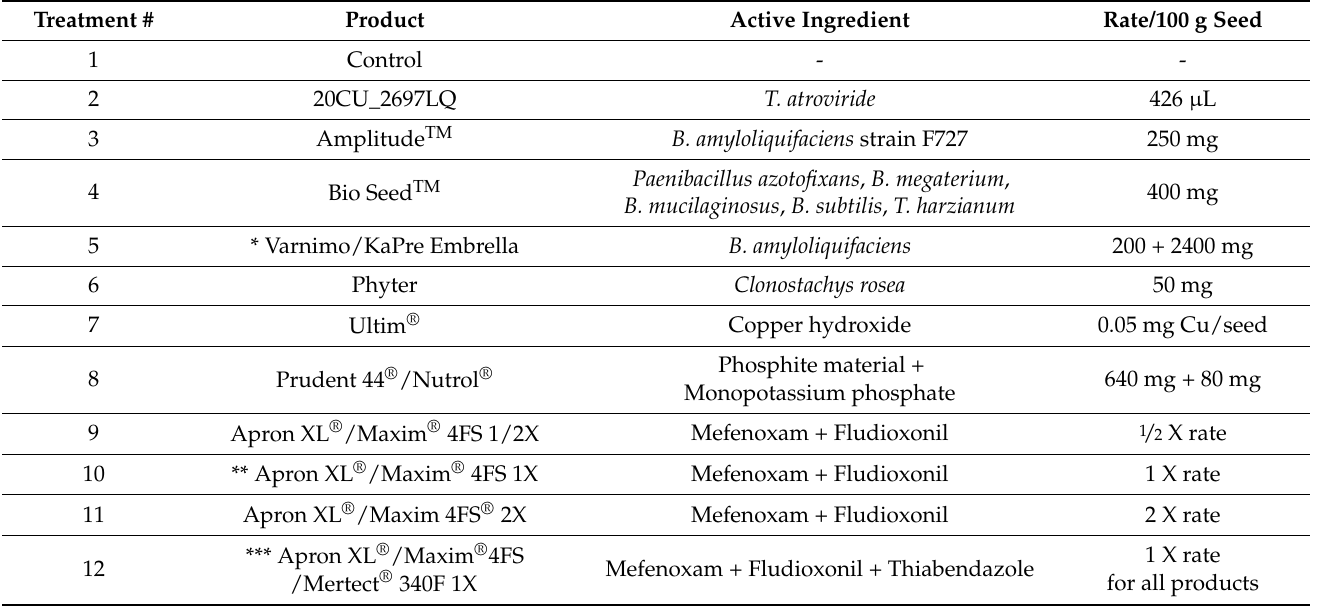
Table 1. Seed treatments were applied to the Anka hemp seed lot with a laboratory-scale rotary pan